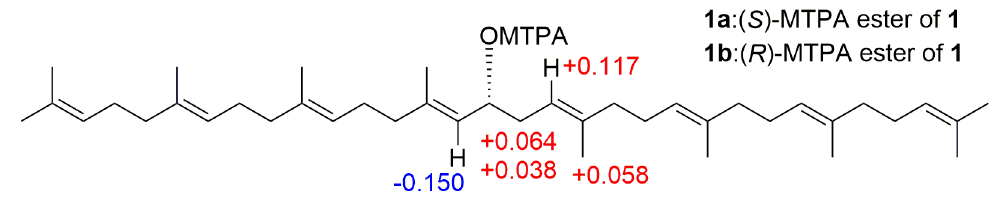
∆ δ ∆ δ = δ − δ Figure 3.  H (  H =  S −  R ) values obtained of ( S )- and ( R )-MTPA esters ( 1a and 1b ). Figure 3. S R ) values obtained of ( S )- and ( R )-MTPA esters ( 1a and 1b H ( H